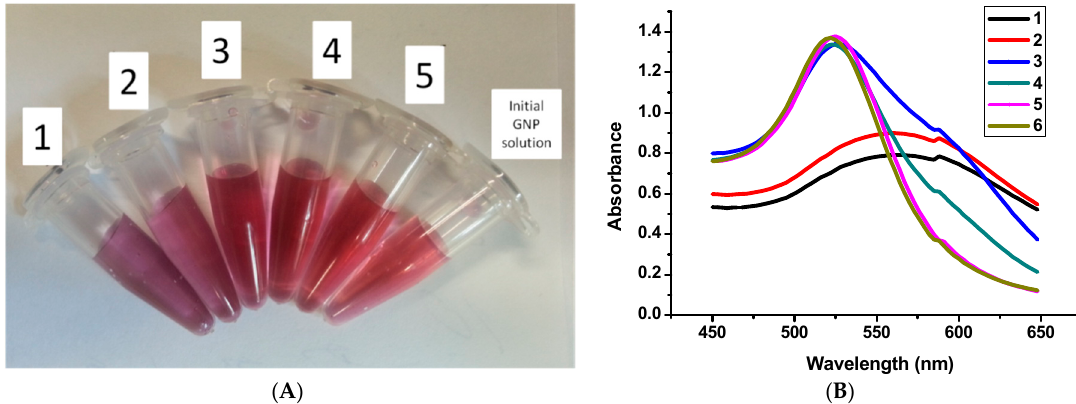
Figure 3. Dependence of the degree of aggregation of GNP conjugates with Mab 2H3C6 on the number of centrifugation cycles through Amicon Ultra 30 kDa filters. 1–5: centrifugation cycles, 6: initial solution of GNPs. ( A ) The appearance of colloidal solutions after adding 10 μ g/mL Mab 2H3C6. ( B ) The absorbance spectra of 1–6 solutions.